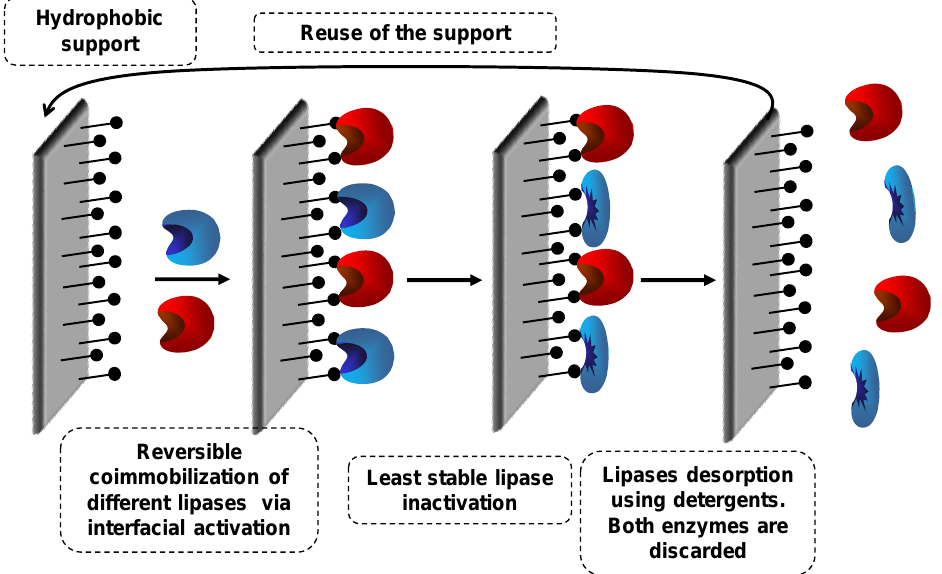
Figure 25. The problem of coimmobilizing two lipases with di ff erent stabilities via interfacial activation on hydrophobic supports: when the least stable enzyme is inactivated, both enzymes may be released from the support enabling the reuse of the